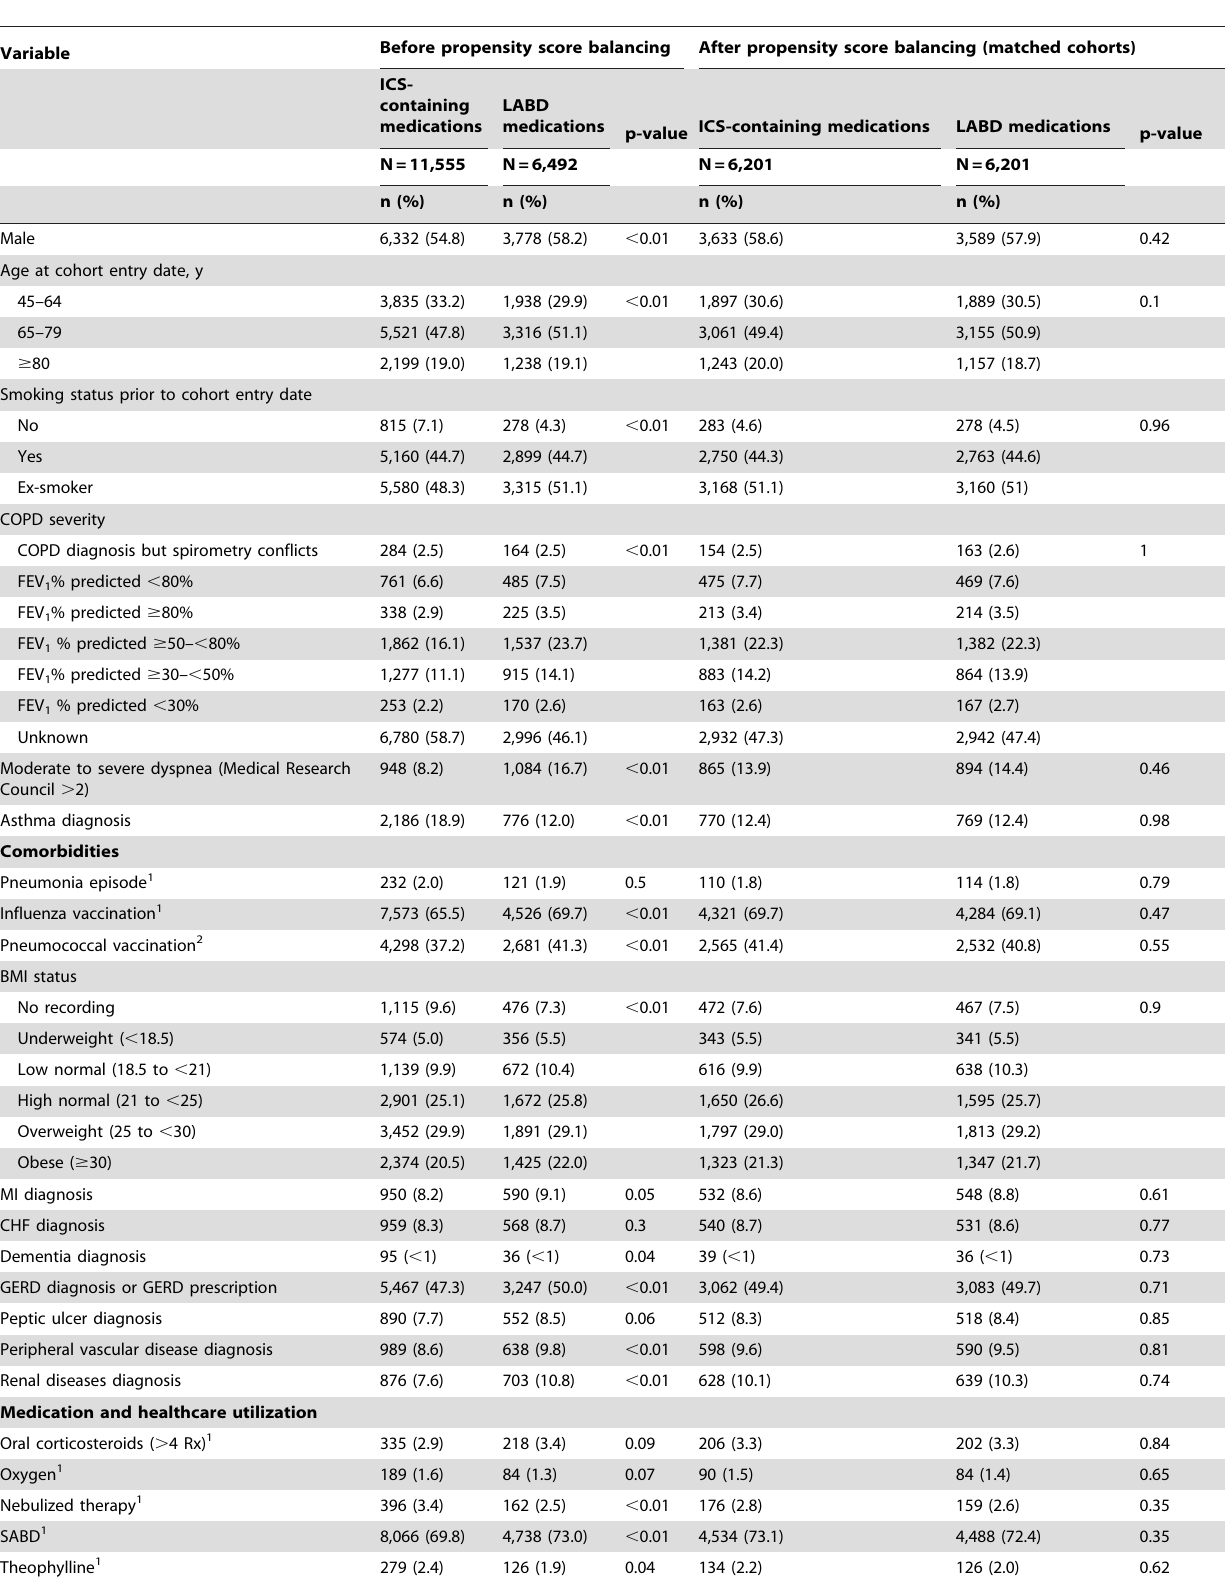
Table 2. Demographics from the Baseline Period (Year Before Cohort Entry) and Patient History for the Final Analysis Cohort Before and After Propensity Score